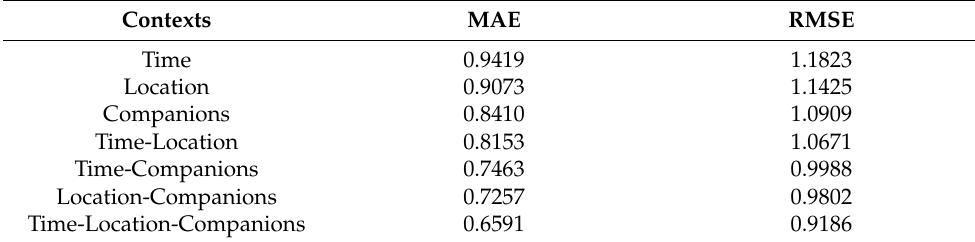
Table 10. Numerical Results of CBMF method on the De Paul Movie